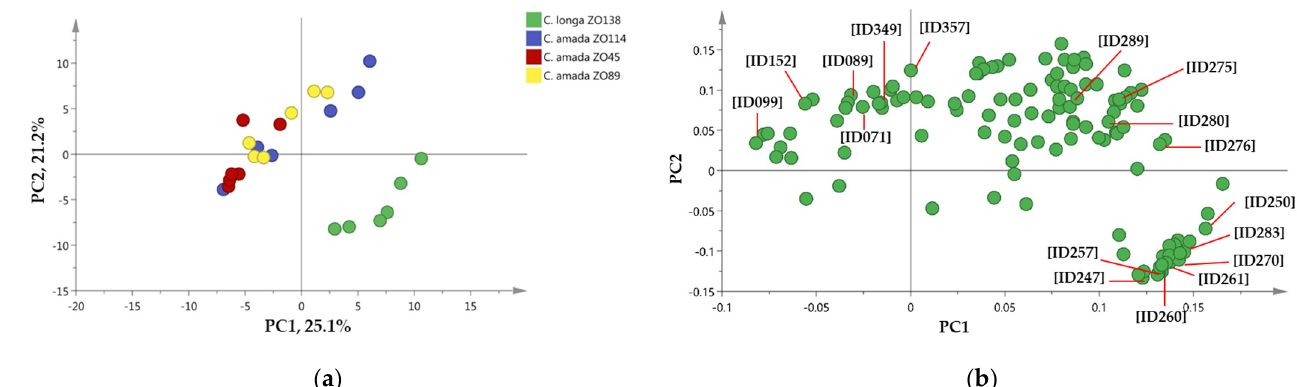
Figure 1. Principal component analysis (PCA) score ( a ) and loading ( b ) plots of the volatile organic compound (VOC) profiles of the Curcuma amada and C. longa samples. Principal components one and two (PC1, PC2) represent the first two principal components that account for a total of 46.3% of the variance. Loading plot indicated some representative compounds contributed to separation of the analyzed Curcuma species. Indicated compound IDs and names: [ID071], β -myrcene; [ID089], o-cymol; [ID099], 1,8-cineole; [ID152], camphor; [ID247], β -elemene; [ID250], α -funebrene; [ID257], α -santalene; [ID260], trans - α -bergamotene; [ID261], teresantalol; [ID270], α -santalol; [ID275], γ -curcumene; [ID276], cuparene; [ID280], α -zingiberene; [ID283], β -bisabolene; [ID289], β -sesquiphellandrene; [ID349], ar-turmerone; [ID357], ( Z )- γ